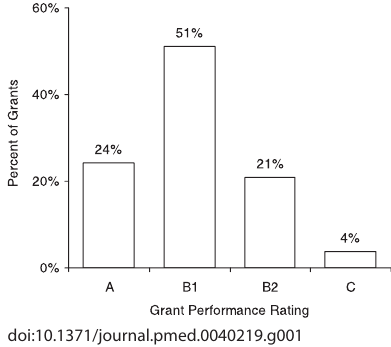
Figure 1. Variability in Performance of 215 Grants Evaluated by December 1, 2006 A: met or exceeded performance. B1: adequate performance. B2: inadequate performance but demonstrated potential. C: unacceptable